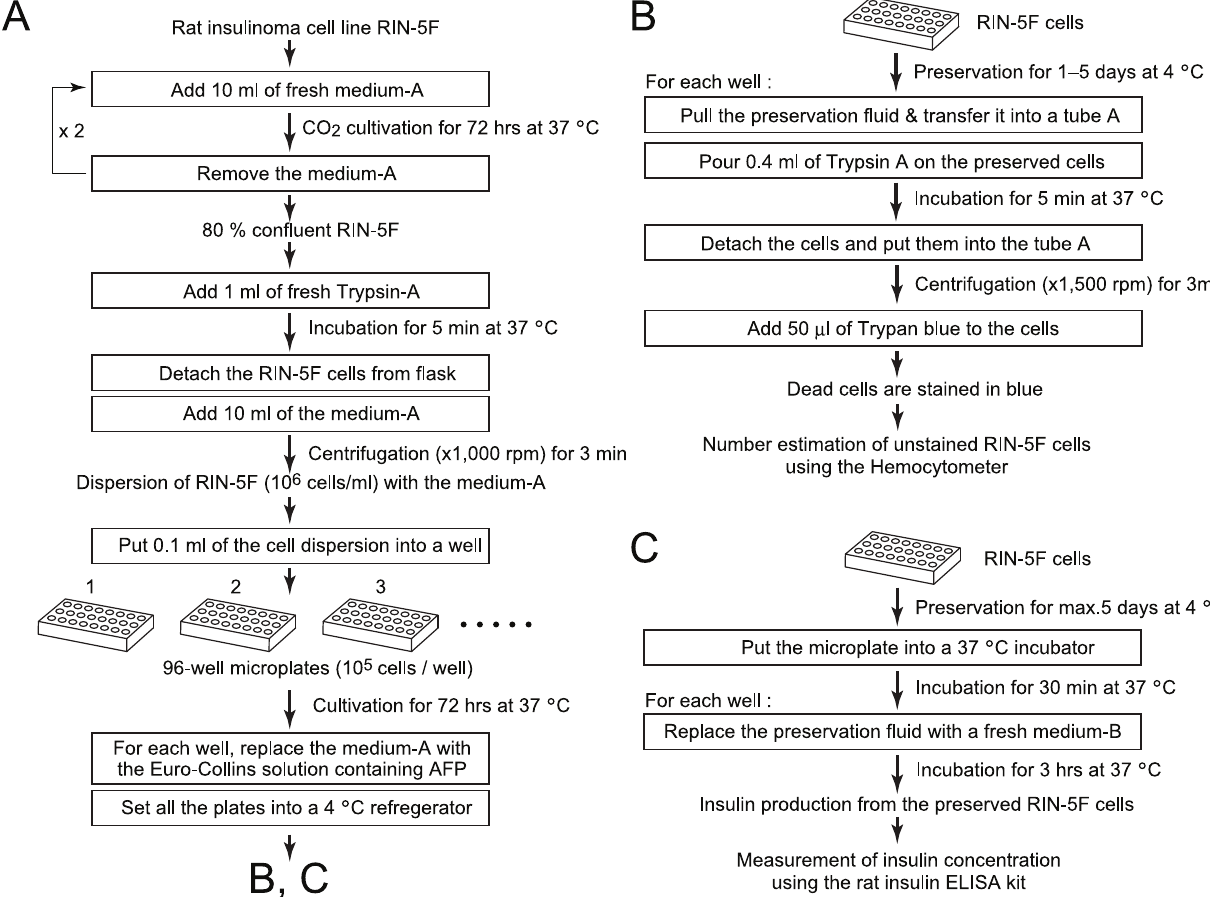
Figure 1. Flow-charts showing the preparation of RIN-5F cells and their survival rate evaluation. A. Preparation of RIN-5F cells before starting 1–5-day preservation experiments at + 4 u C. B. Procedures to estimate the number of living cells using the hemocytometer. C. Procedures to measure the amount of insulin secreted from the living cells. Medium-A consists of RPMI-1640 medium containing 10% of fetal bovine serum (FBS). Medium-B consists of the medium containing 1% of FBS. Trypsin-A consists of 0.25% bovine trypsin plus 1 mM of EDTA dissolved in phosphate buffered saline (PBS).